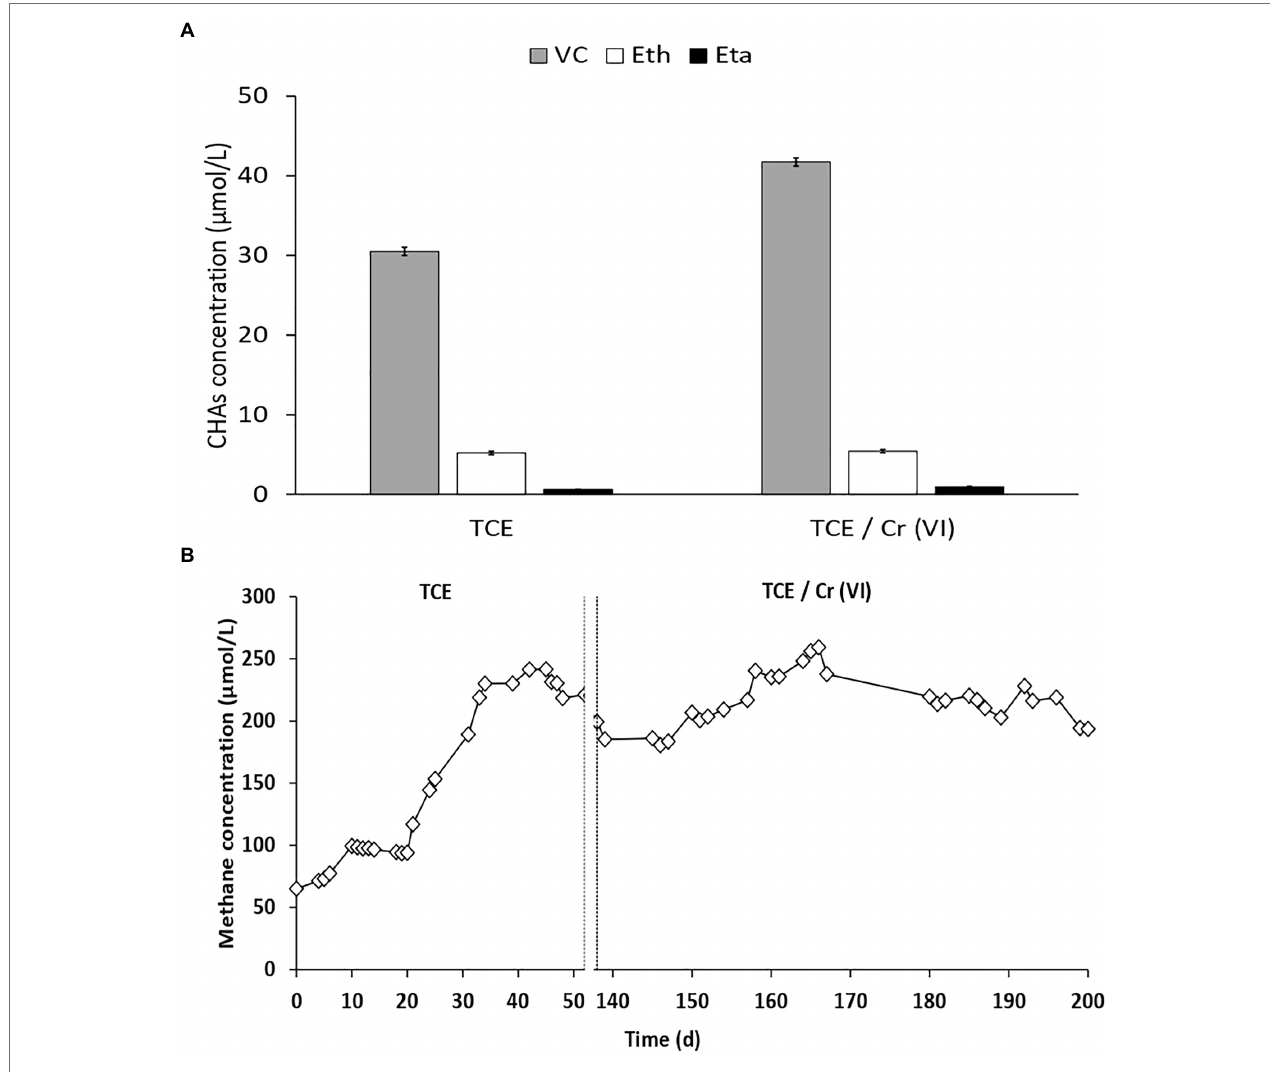
FIGURE 2 | (A) Distribution of the reductive dechlorination (RD) products observed in the cathode outlet TCE and TCE/Cr(VI) operating conditions. (B) CH 4 concentrations in the cathodic effluent of the bioelectrochemical reactor during all the system’s operation periods, including the runs with TCE and